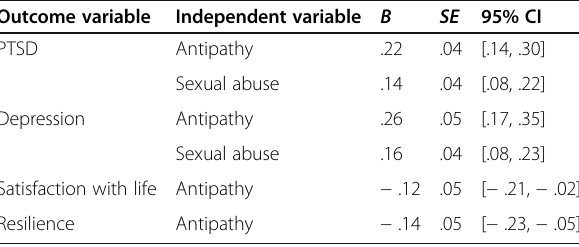
Table 4 Indirect effects in mediation analysis models Outcome variable Independent variable